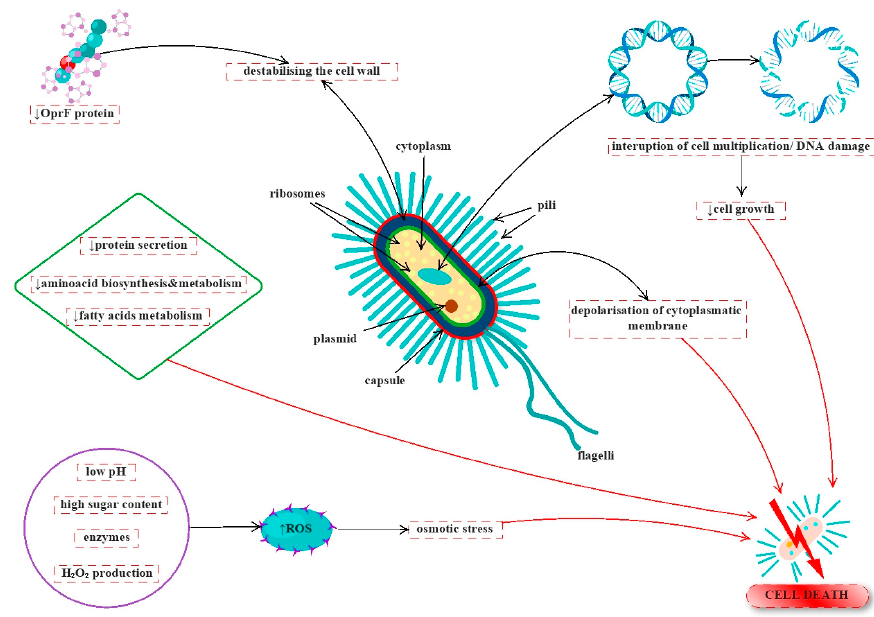
Figure 4. Antimicrobial mechanisms of honey. The figure was designed with ConceptDraw Dia- gram